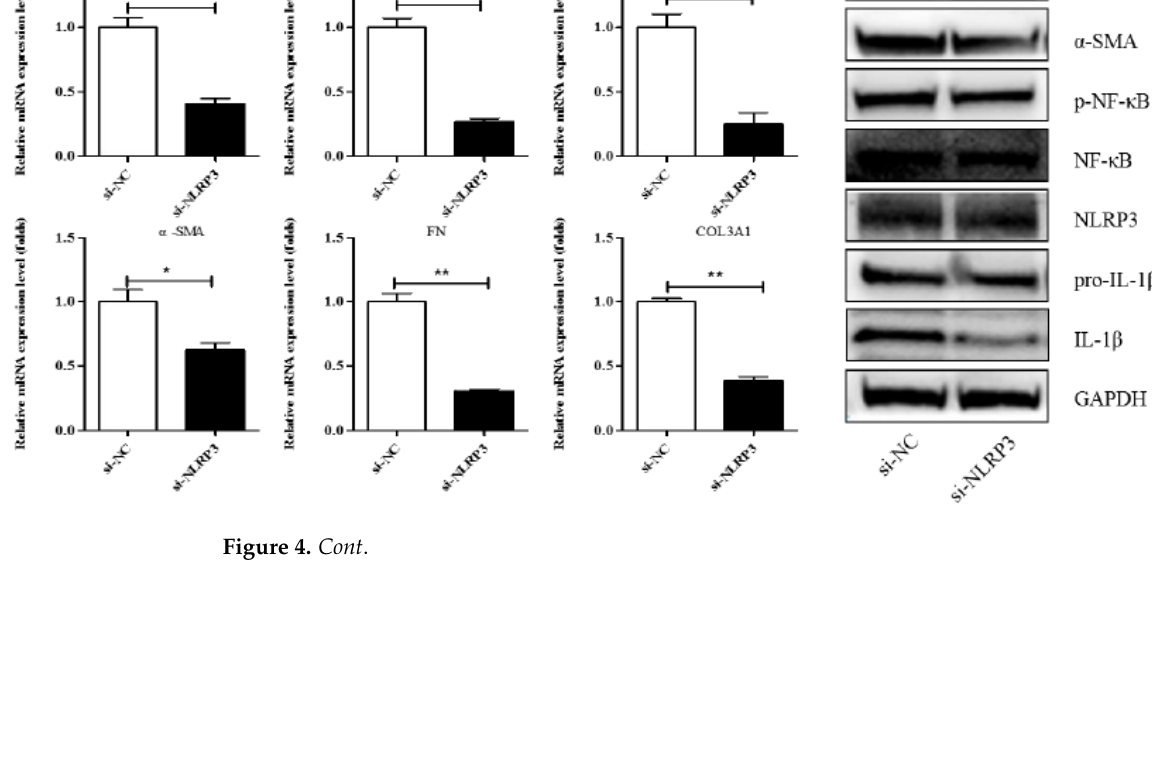
Figure 4. Effects of si-NLRP3 on inflammation and liver fibrosis in LX-2 cells. LX-2 cells were trans- fected transiently with siRNA-NLRP3 for 48 h. ( A ) Real-time PCR analysis showed that the levels of NLRP3, IL- 1β, IL - 18, α -SMA, COL1A1 and COL3A1 mRNA were significantly downregulated by NLRP3 silencing. ( B ) The protein expressio n levels of α -SMA, FN, p-NF- κB, and IL- 1β decreased dramatically after LX-2 cells were induced to down-express NLRP3. ( C , D ) Expression of the above genes at the mRNA and protein levels in LX-2 cells, when LX-2 cells were transfected transiently with siRNA-ARRB2 for 48 h (n = 3). Student’s t -test was used for statistical analysis. The results shown are mean ± standard error. * p < 0.05, ** p < 0.01. 3.5. Treatment with Asp Blocked Hepatic NF- κB/NLRP3 Expression In Vitro and In Vivo To clarify the role of NLRP3 in liver fibrosis, we further tested whether Asp had an effect on gene NLRP3 expression in liver fibrosis. In vitro, LX-2 cells were stimulated with lipopolysaccharide (LPS) (1 and 2 μg/mL) for 6 h. At the concentration of 1 μg/mL, the cells obviously had an inflammatory response, and when the concentration increased to 2 μg/mL, more cells died. Therefore, the optimal concentration of LPS in LX-2 cells was 1 μg/mL (Figure 5A). The supernatant was then transferred to LX-2 cells with or without Asp. The NLRP3 inflammasome and HSCs were activated by LPS; Asp significantly in- hibited LPS-activated NLRP3 inflammasome and HSC activation (Figure 5B). At the same time, Asp lowered the activation of HSCs in a time- and concentration-dependent manner